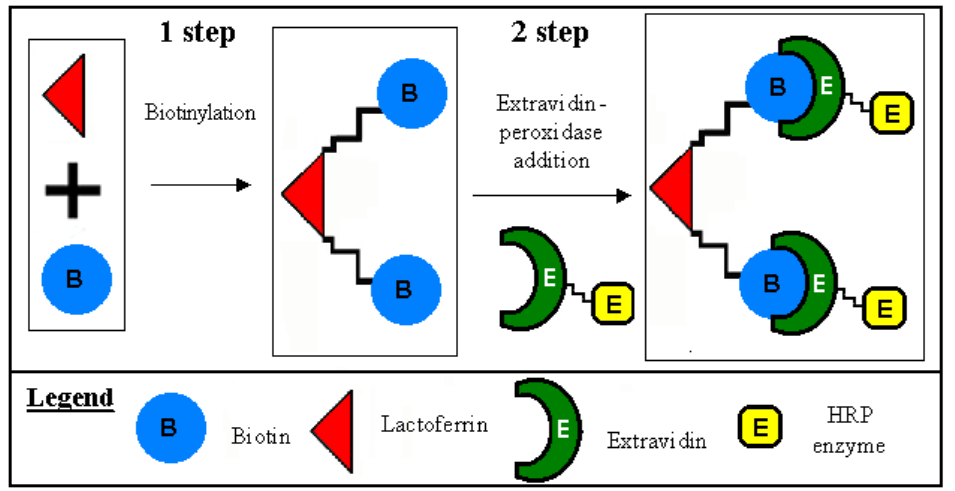
Figure 1. Biotinylation and conjugation of the